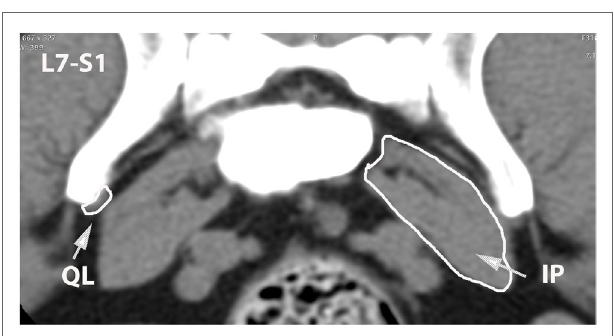
FIGURe 13 | transverse Ct image at the level of L7–s1, illustrating margins of the quadratus lumborum (QL) and iliopsoas (IP) muscles .